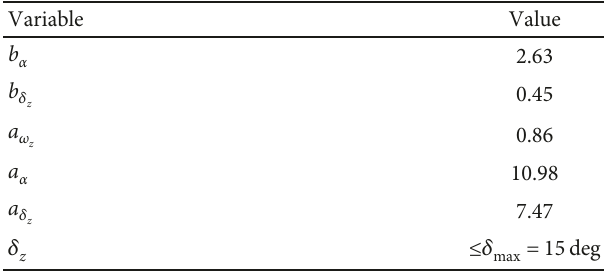
Table 1: The parameters for a dual-control missile.